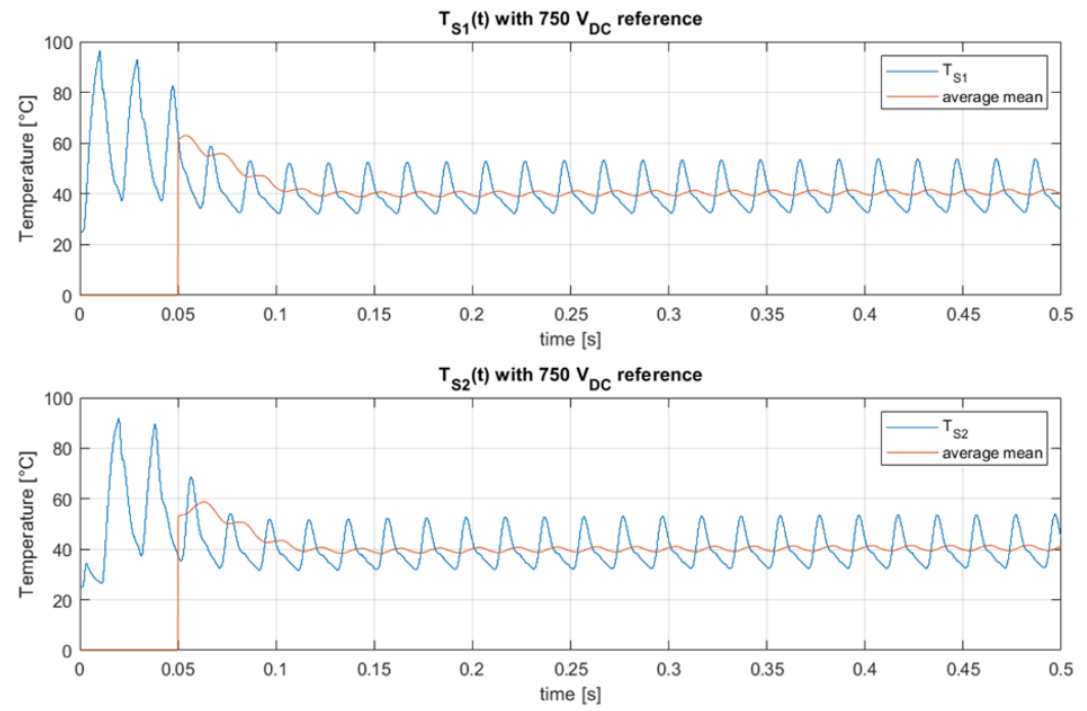
Figure 27. Thermal behavior of the SiC switching devices in the Totem Pole